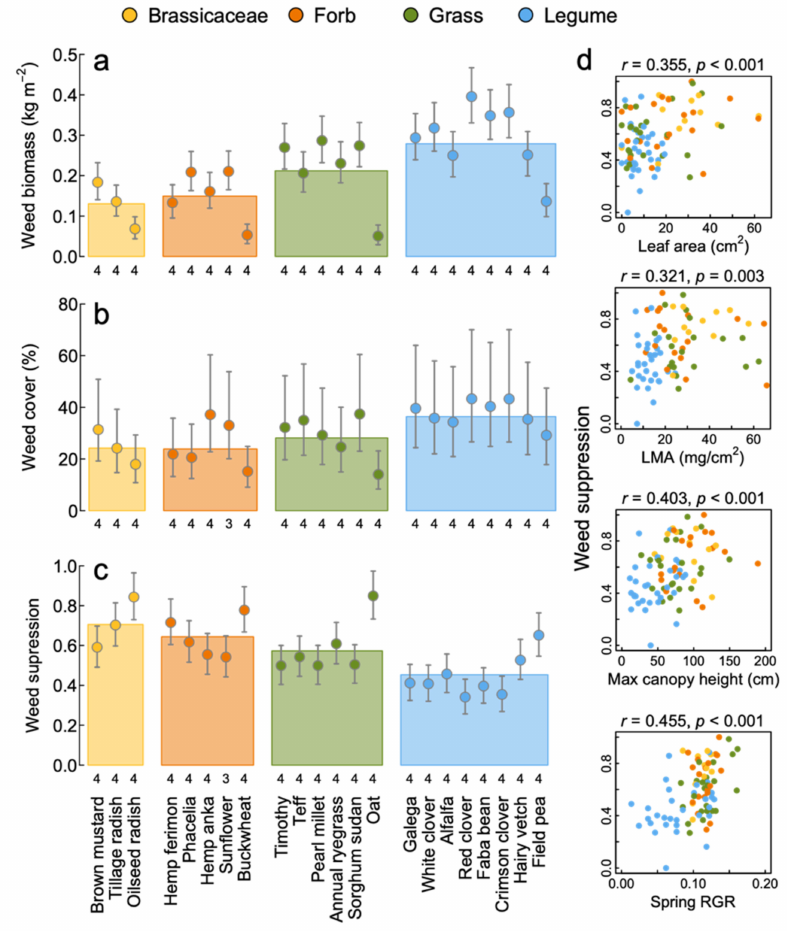
Figure 3. Weed suppression. Weed biomass ( a ), weed cover ( b ) and the inverse of their scaled average as weed suppression ( c ) among difference crops. Points show means, and error bars are model estimates of standard errors for comparison among means of the crops. The colored bars show overall means for each plant functional group (indicated by the different colors). Numbers below each mean are the number of replicates used. Statistics are provided in Table 2. Significant correlation (Spearman) between weed suppression and plant functional traits are shown in ( d ). Note weed suppression was not correlated with rooting density ( r = 0.141, p = 0.192). Note, LMA = leaf mass per area and RGR = relative growth